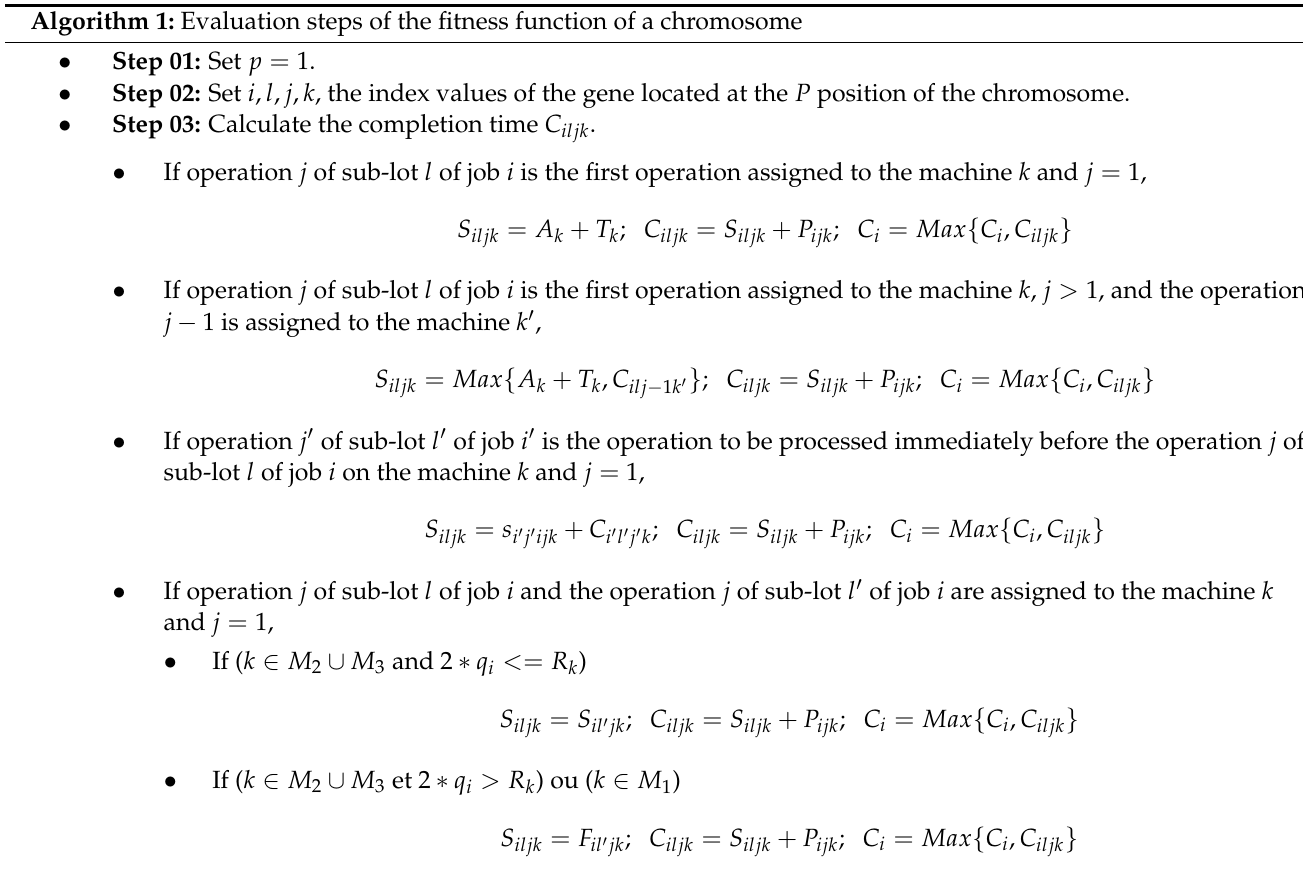
Algorithm 1 decodes the chromosomes to obtain the objective function value and a workable representation of the solutions. Algorithm 1: Evaluation steps of the fitness function of a